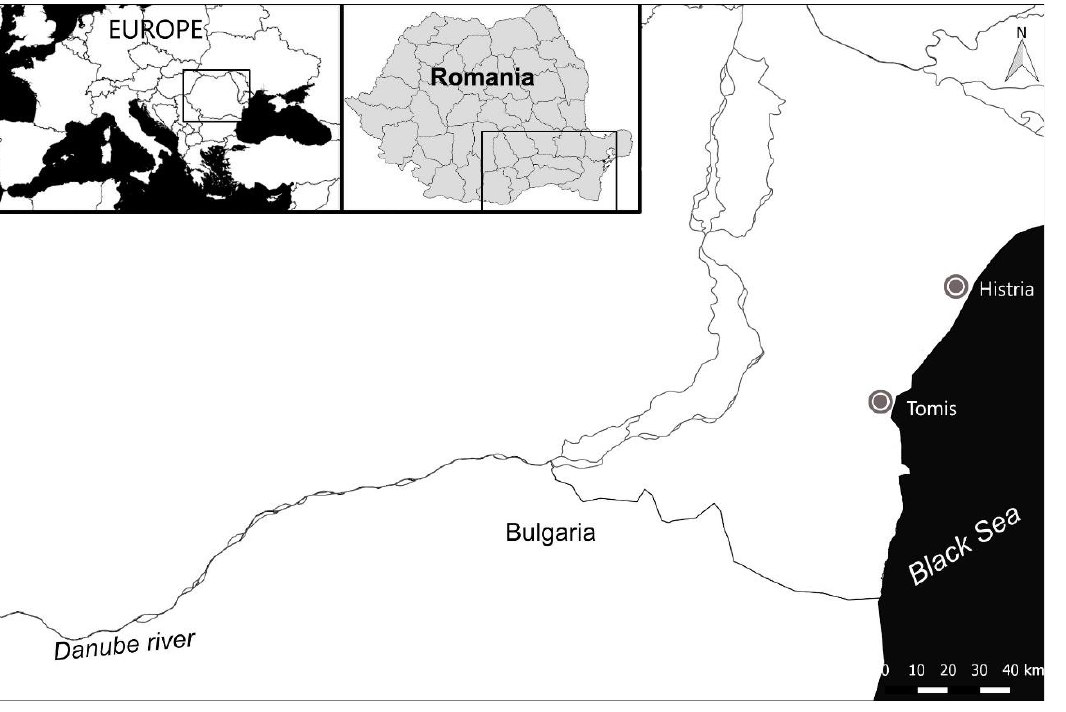
Figure 1. Maps showing the location of the archaeological sites where the glass fragments reported in this paper were